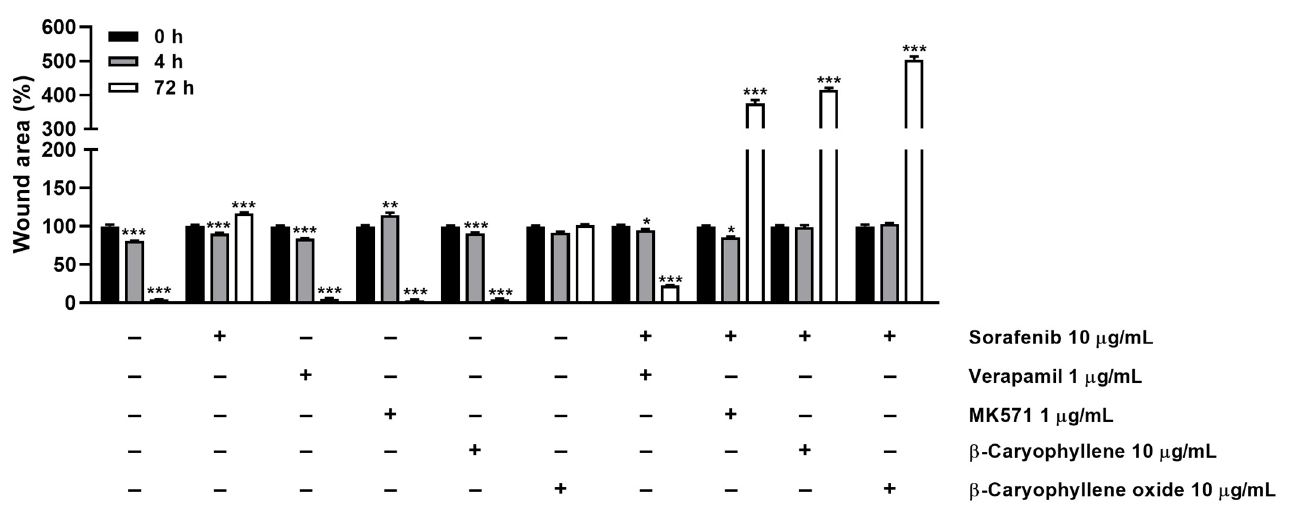
Figure 13. Quantification of Bx-PC3 cells migration rate analyzed by ImageJ at 0 h, 4 h, and 72 h ( n = 3) after treatment with sorafenib (10 µg/mL), β -caryophyllene (10 µg/mL), β -caryophyllene oxide (10 µg/mL), verapamil (1 µg/mL), and MK571 (1 µg/mL) alone or in combination with the anticancer drug. Results are reported as mean ± SE of wound area percentage of at least two independent experiments ( n = 2). * p < 0.05, ** p < 0.01, and *** p < 0.001 (one-way ANOVA followed by Dunnett’s multiple comparison post-test) vs. wound area percentage at 0 h.